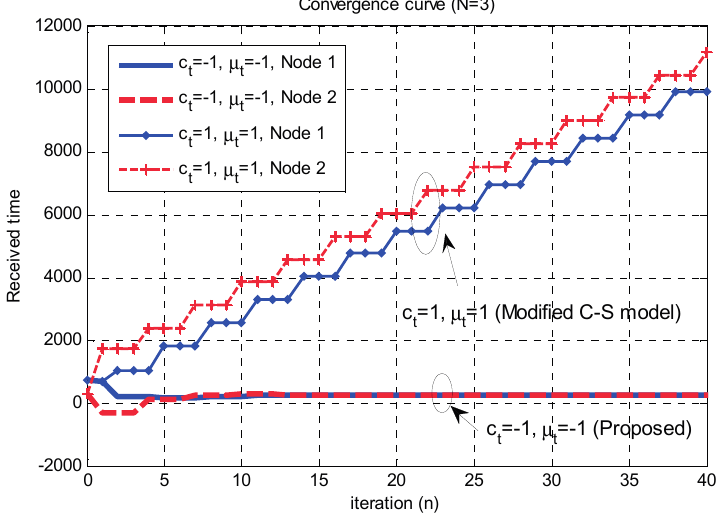
Figure 3. Convergence curves of the modified C-S model and proposed time-synchronization technique with the propagation delays (